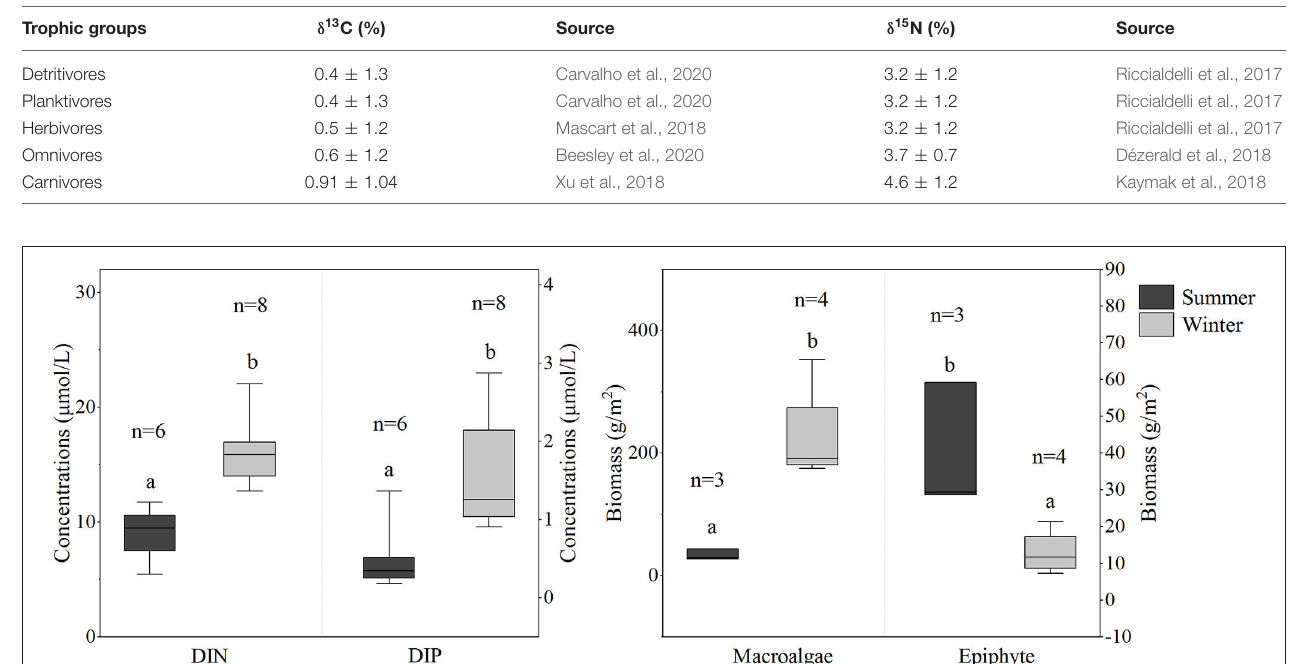
TABLE 1 | Mean ± standard deviation (SD) of trophic enrichment factors (TEFs) used to calculate the contribution of potential food sources to the different trophic groups.